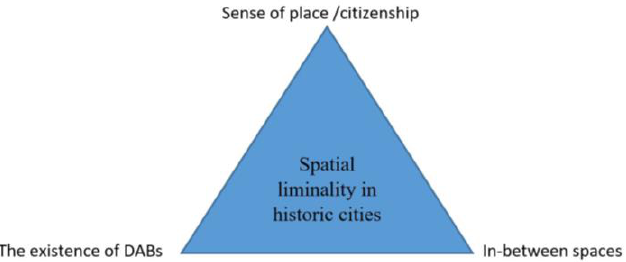
Figure 7. Current multifaceted associations could change levels of spatial liminality in historic cities.